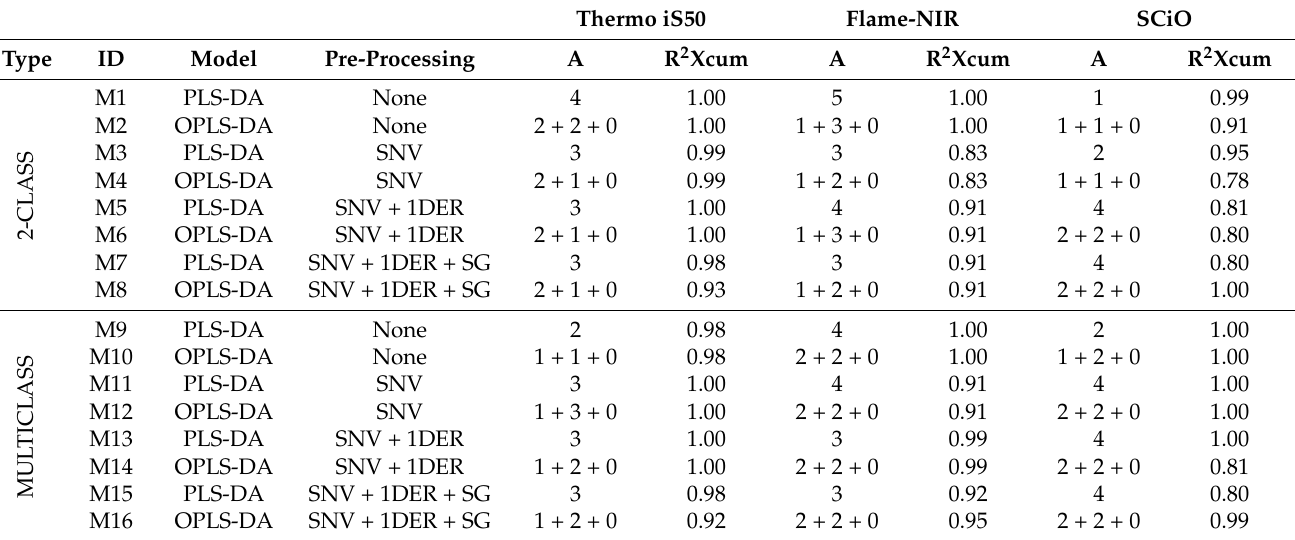
Table A1. Number of factors determined for each